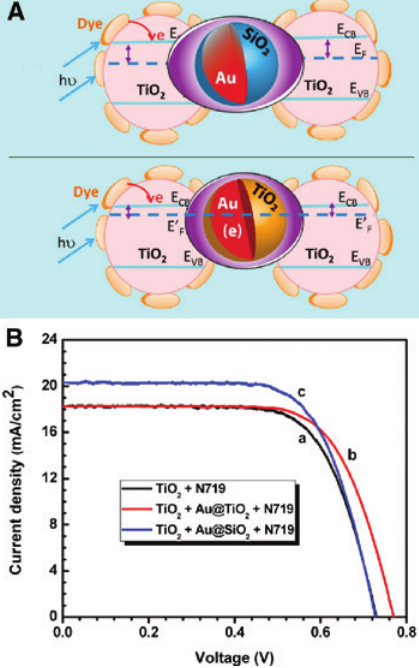
Figure 10: (A) Electron equilibration and its influence on the appar- ent Fermi level (E (B) J – V characteristics of DSCs with TiO TiO . Reprinted with permission from [56]. Copyright 2012 American 2 Chemical Society.